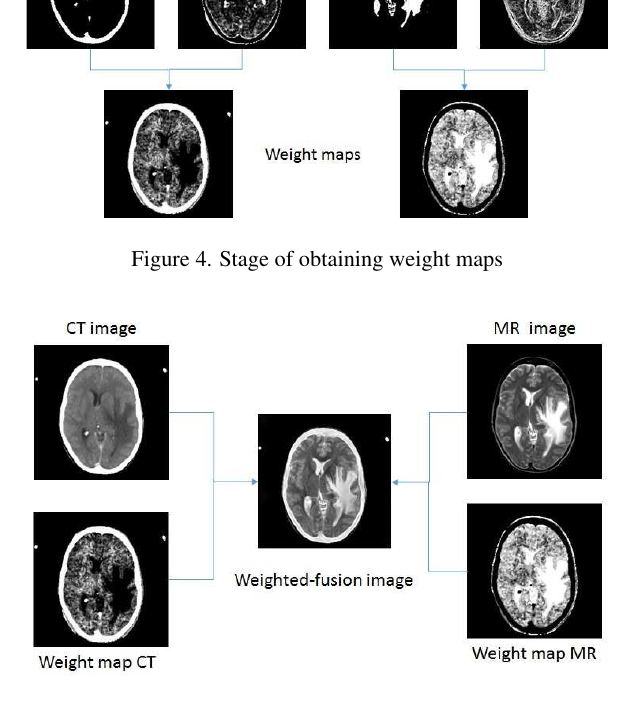
Figure 5. The process of obtaining the weighted-fusion image The weighted-fusion result can be blurred and had some noise because of different grey matter and white matter distribu- tions on original CT and MR images. We use the structure- transferring filter based on the probabilistic gamma-normal model to eliminate this effect and smoothed image acquisition.